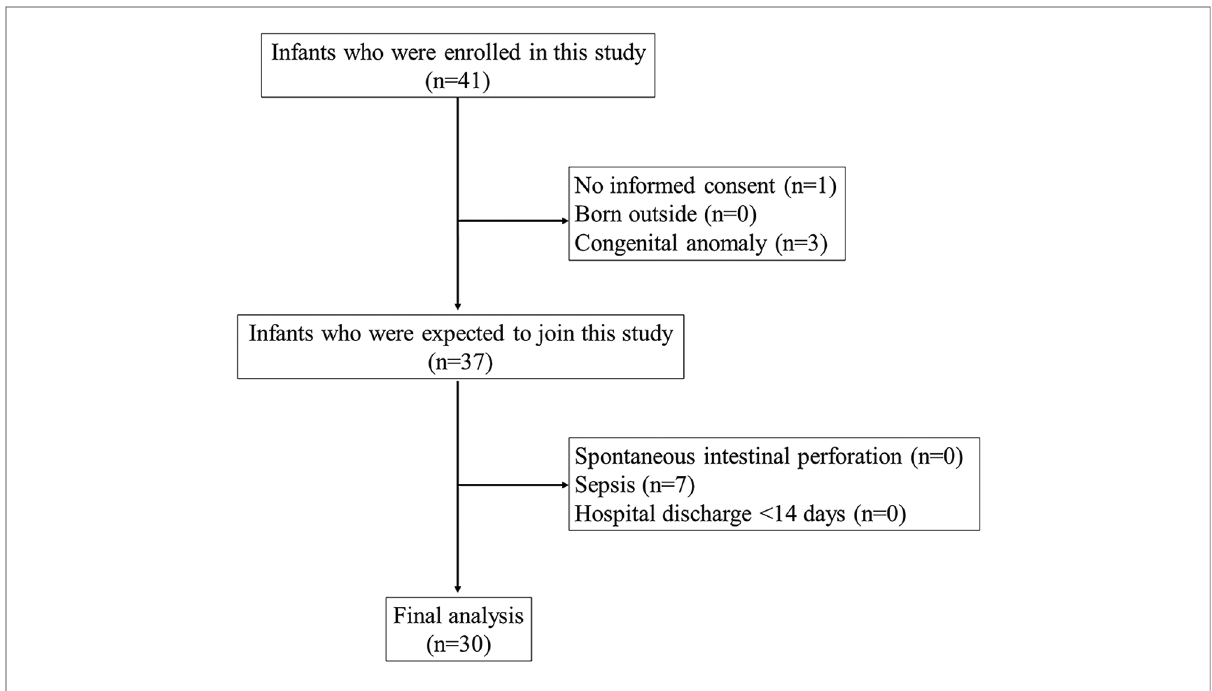
FIGURE 1 The study fl ow chart of participant